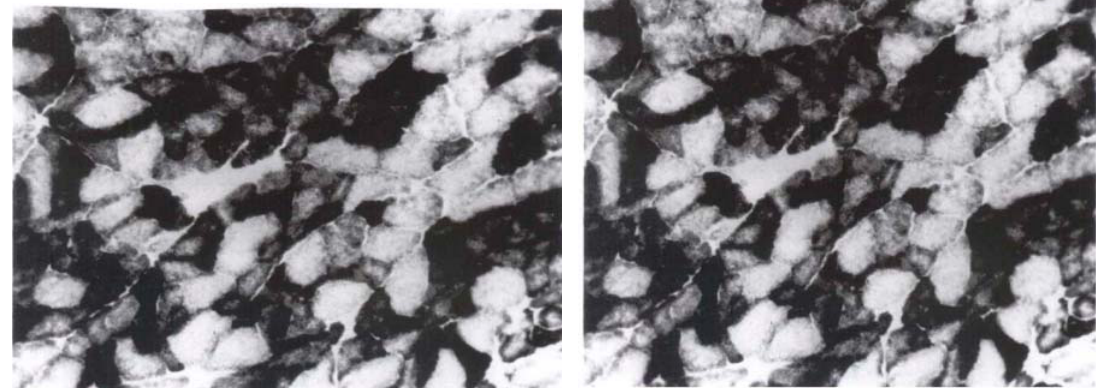
Figure 3a. SDH stain, plantaris muscle, 30-month old sedentary. Figure 3b. SDH stain, plantaris muscle, 30-month old exercised.